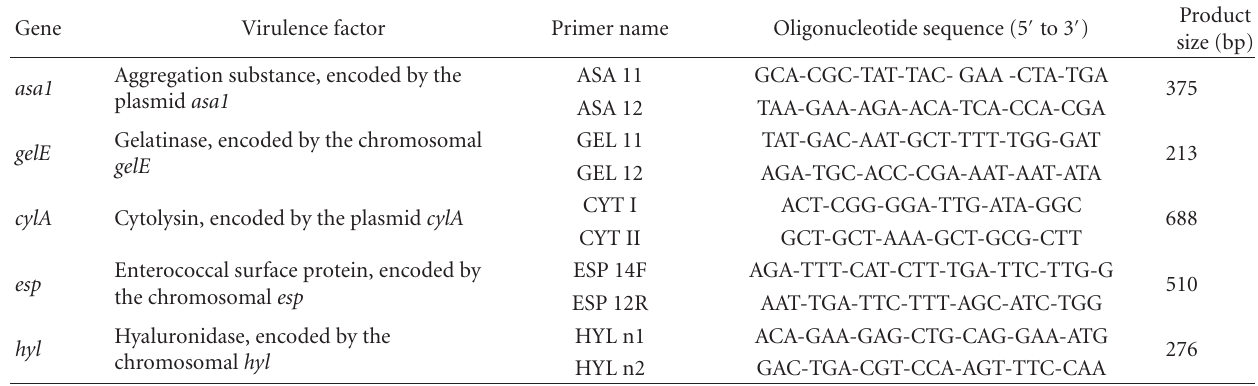
Table 3: Oligonucleotide primers used to amplify virulence factor genes.